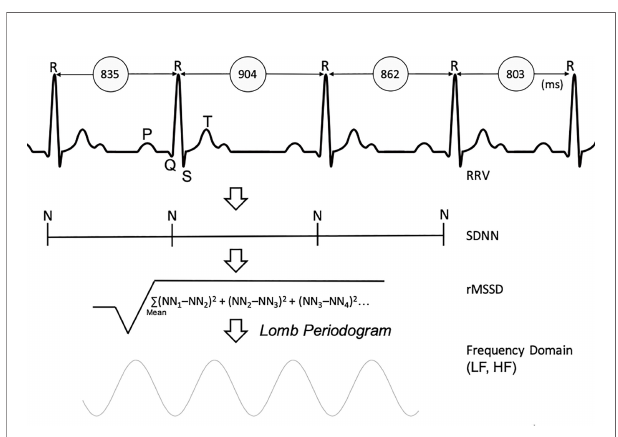
FIGURE 2 | Derivation of Heart Rate Variability parameters. RRV, R-to-R variability; SDNN, standard deviation of normal-normal heart beats; rMSSD, root mean square of successive differences; LF, low frequency; HF, high